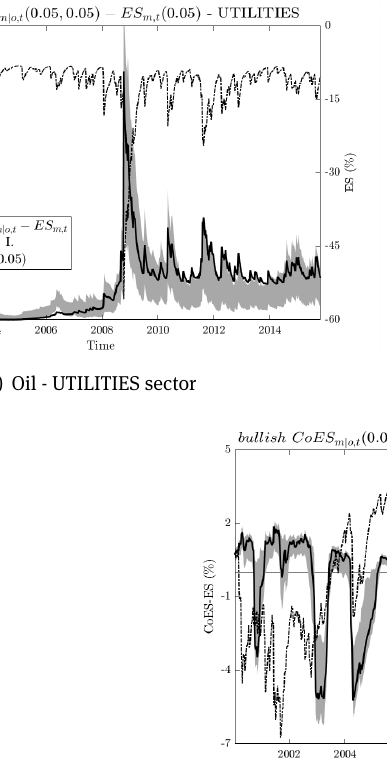
(k) Oil - TECHNOLOGY sector Left axis shows the difference in percentage between the CoES (0.05, 0.05) of the returns for a certain sector under a extreme m , t upward movement in oil prices, i.e. above its 95-th quantile, and its unconditional ES (0.05). Solid blue line shows this m , t difference given the best copula mixture according to Table 6.Grey area indicates the 90% confidence interval of the difference between CoES (0.05, 0.05) and ES (0.05) following a Monte Carlo technique explained in Appendix C. The right axes m , t m | o , t shows the value of the ES (0.05) in percentage. The dash-dotted black line indicate the ES level over m , t